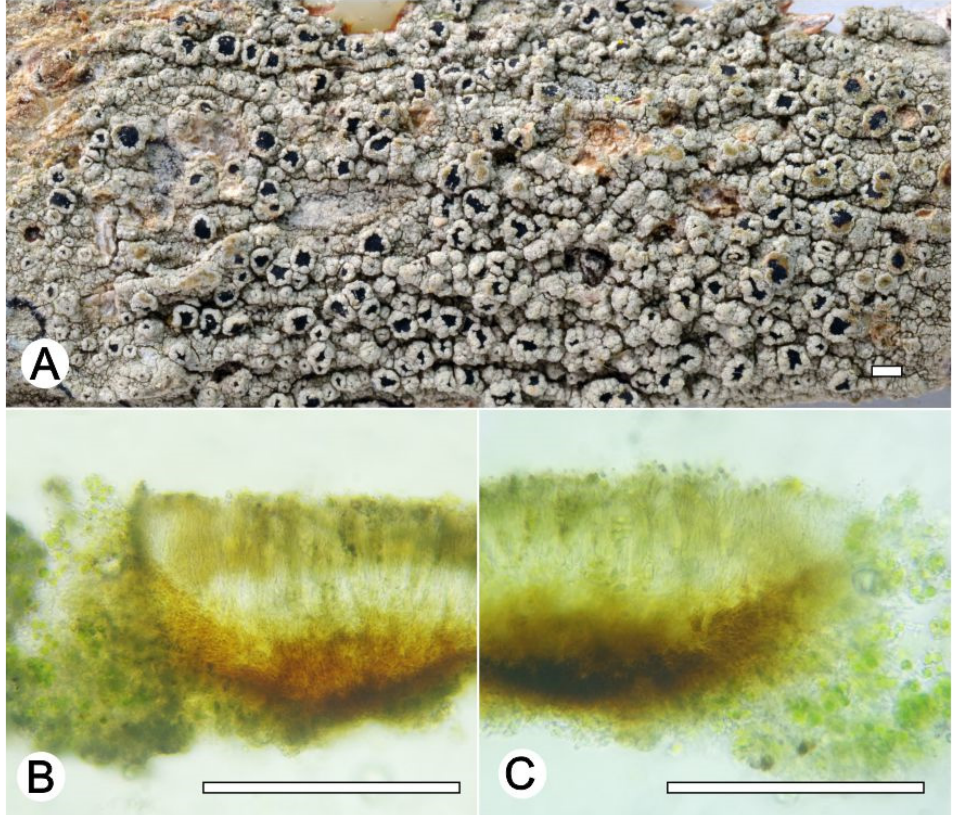
Figure 13. Lecanora xanthoverrucosa sp. nov. ( A ) Thallus with ascomata (holotype ISE-52394); ( B ) Apothecial section in water (holotype ISE-52394); ( C ) Apothecial section after KOH treatment (holotype ISE-52394). Scale bars: ( A ), 1 mm; ( B , C ), 100 µm. MycoBank MB